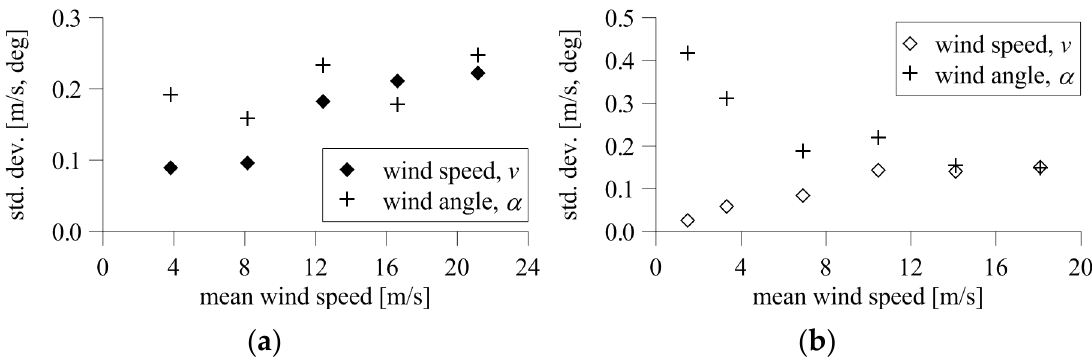
Figure 16. Standard deviation of wind speed and angle at changing flow speed for ( a ) 2D anemometer and ( b ) 3D anemometer.